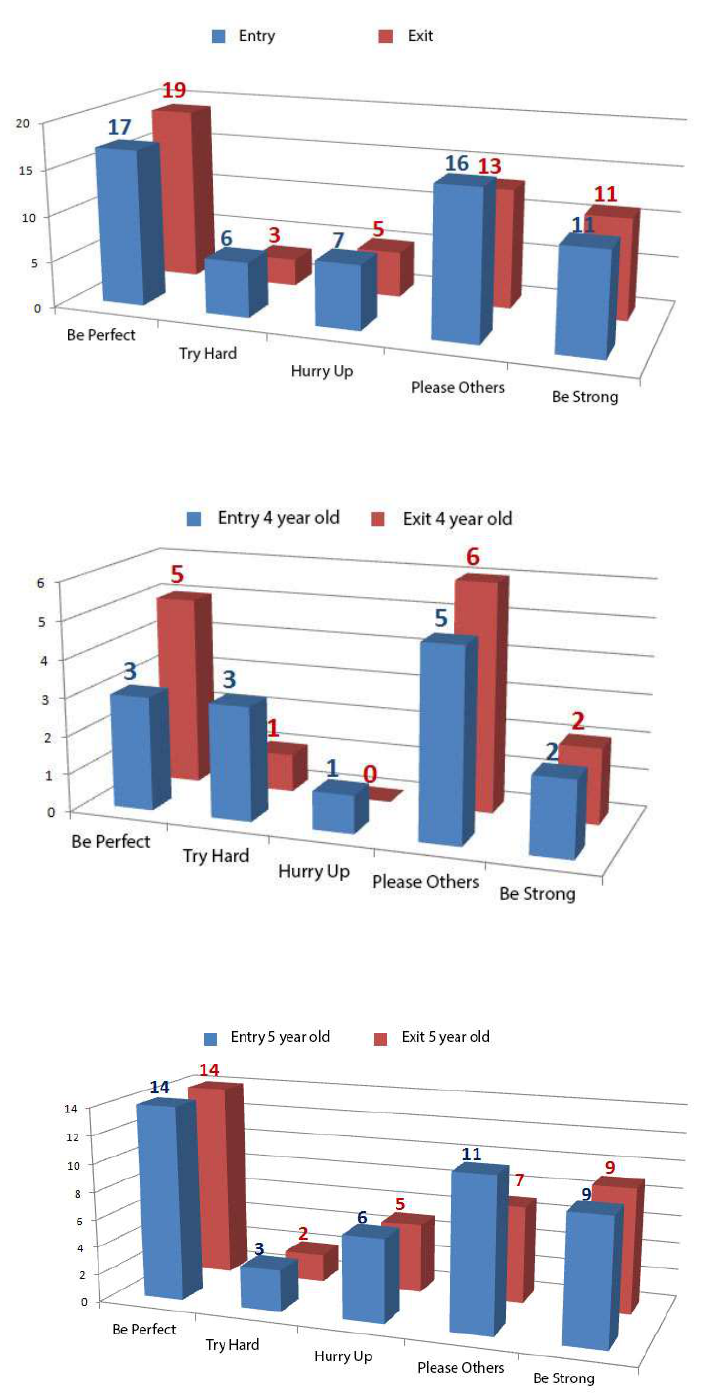
Figure 3: Driver Questionnaire Entry and Exit Level